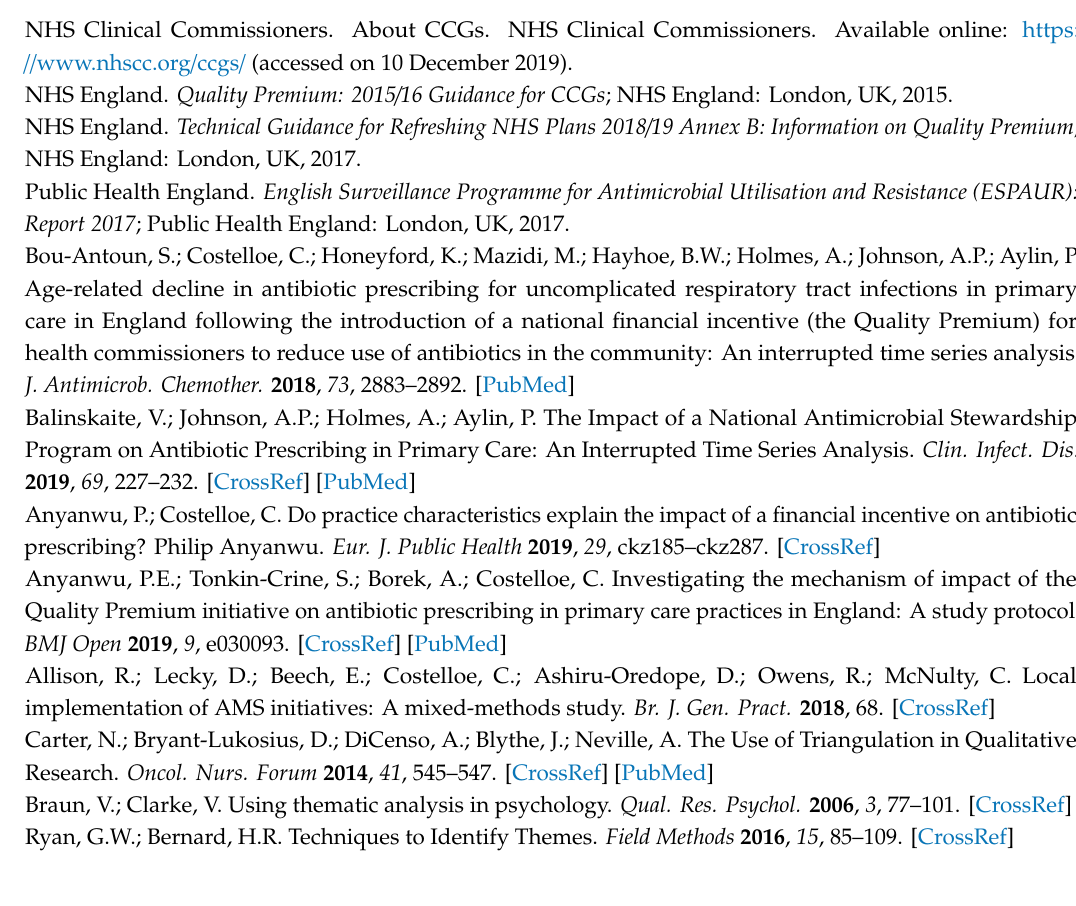
Figure S1: Initial Conceptual Model Group 1, Figure S2: Initial Conceptual Model Group 2, Figure S3: Initial Conceptual Model Group